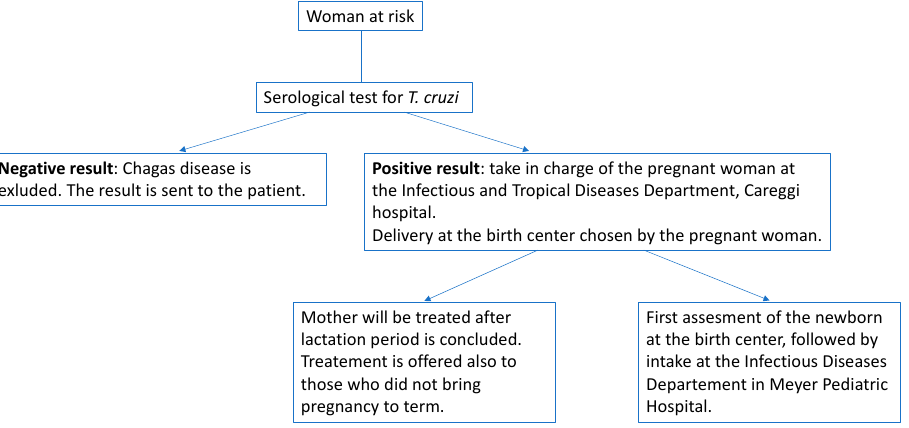
Figure 1. Steps provided by the protocol when a pregnant woman at risk is taken in charge.